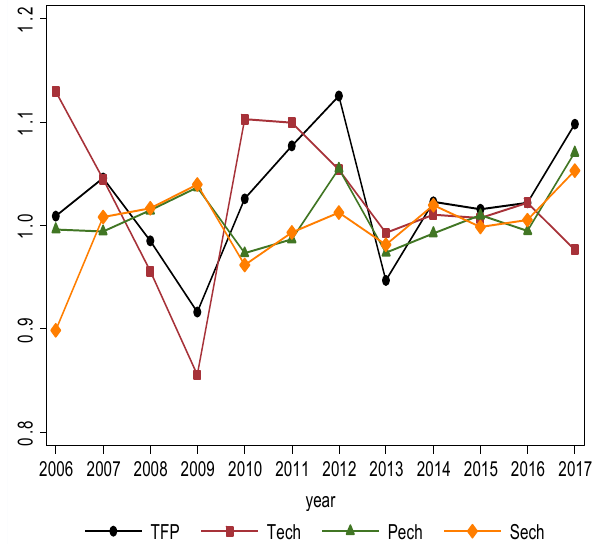
Figure 1. Variation Characteristics of Rice Production Efficiency in China from 2007 to 2018.